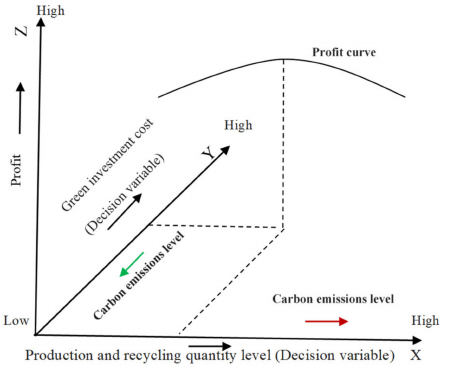
Figure 6. Trade-off between green investment cost, production, and recycling